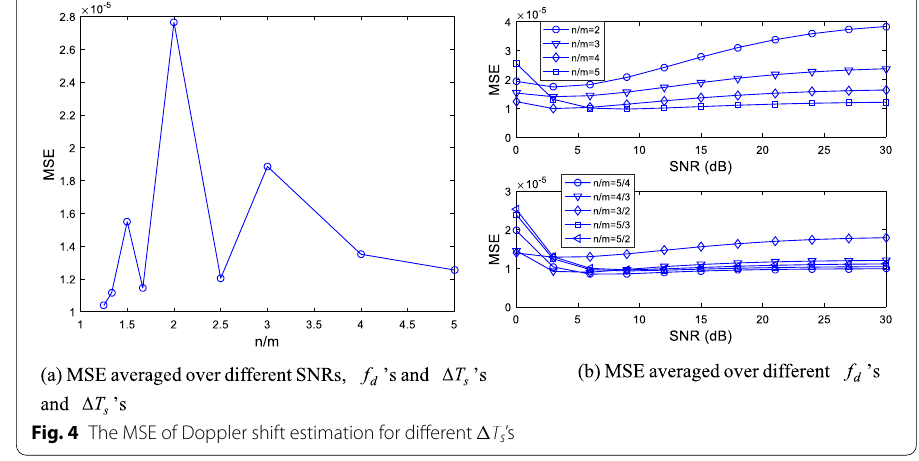
Fig. 4 The MSE of Doppler shift estimation for different (cid:31) T s ’s